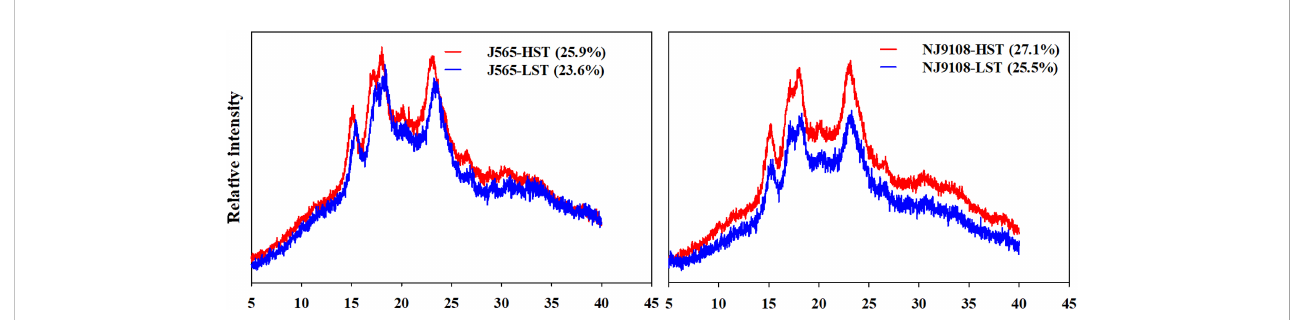
FIGURE 6 The X-ray diffraction (XRD) and relative crystallinity of starch. The data in brackets are the values of relative crystallinity. HST and LST represent high seasonal temperature and low seasonal temperature, during the reproductive stage in 2017 and 2018. J565 and NJ9108 represent cultivars Jing-565 and